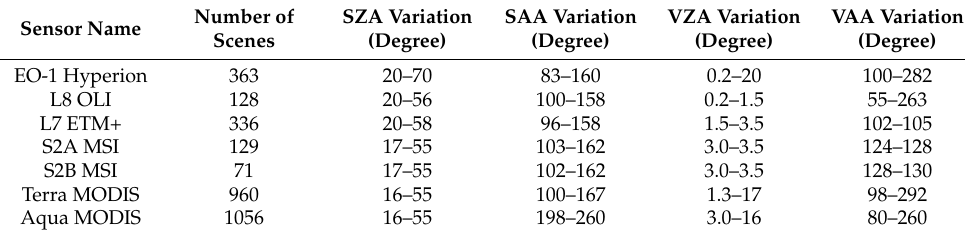
Table 1. Angular variation of different